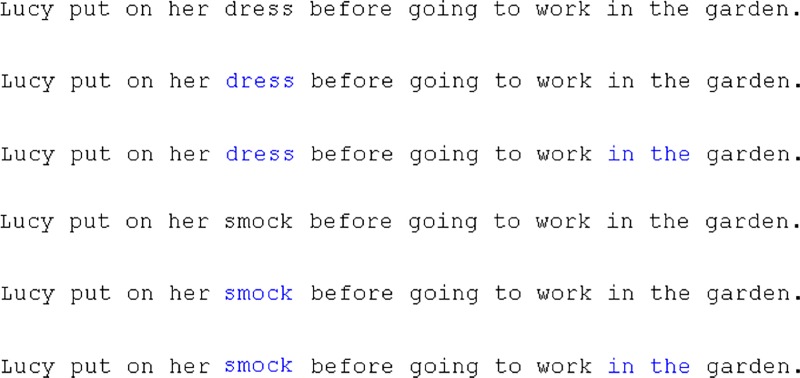
Example stimulus from Experiment 2 of the six different versions of a single stimuli.